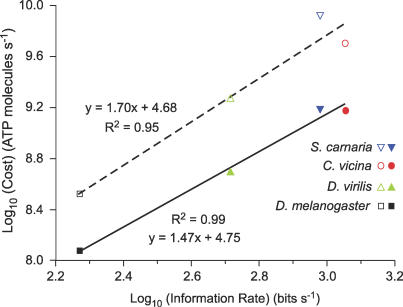
The Scaling of Metabolic Cost with Performance in Dipteran R1–6 PhotoreceptorsThe logarithms of the total cost (open symbols) and the fixed cost (solid symbols) are plotted against the logarithm of maximum information rate. Costs are in ATP molecules hydrolysed per photoreceptor per second. Each data point represents the mean values from R1–6 photoreceptors in one of the four dipteran species used in this study. The linear fits suggest that the total cost of photoreceptor signalling (dashed line) increases as (information rate)1.7, and the fixed cost of maintaining the photoreceptor in the dark (solid line) increases as (information rate)1.47.